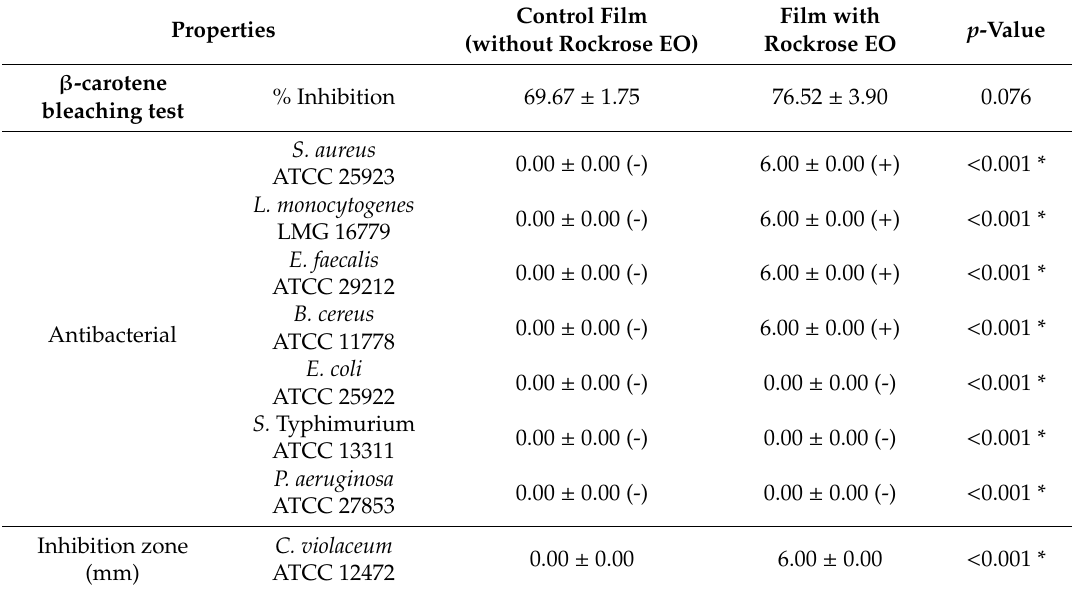
Table 8. Antioxidant activity ( β -carotene bleaching test), antibacterial properties and diameter of inhibition of the violacein production (mm).